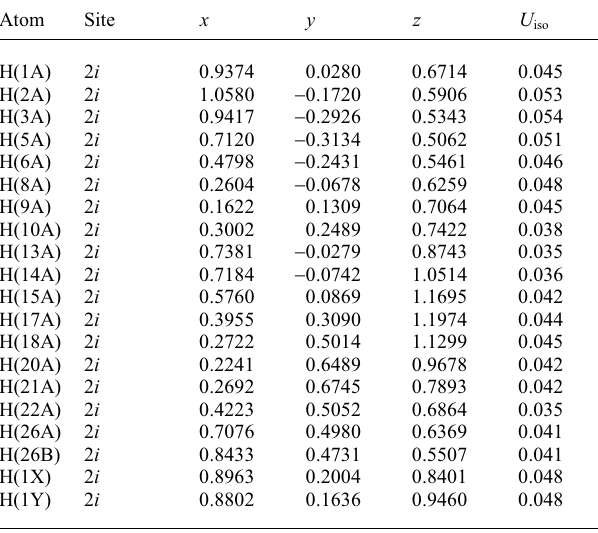
Table 2. Atomic coordinates and displacement parameters (in Å 2 )